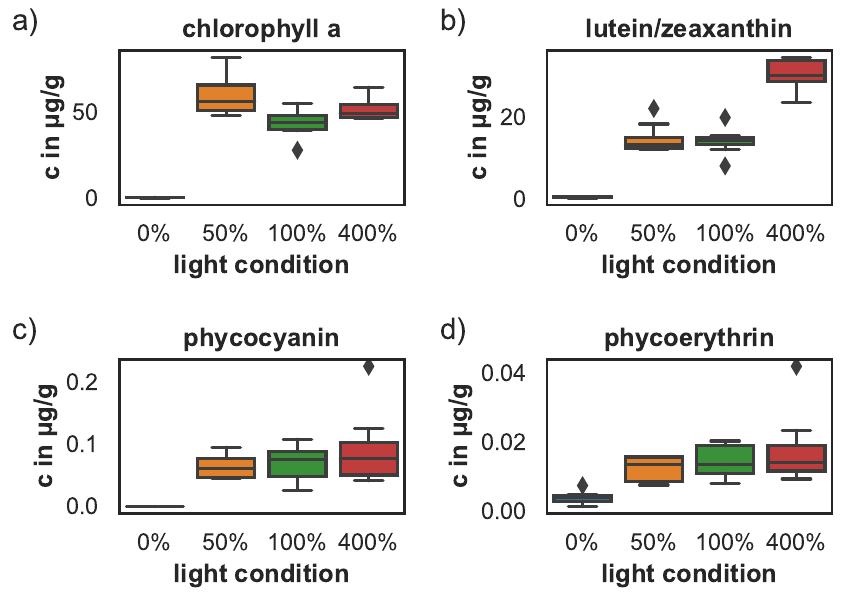
Figure 3. Pigment concentrations after 68 days under varying light conditions. ( a ) chlorophyll a concentrations, ( b ) carotenoid concentrations, ( c ) phycocyanin concentrations, ( d ) phycoerythrin concentrations. The box shows the quartiles of the data-set while the whiskers show the rest of the distribution, except for outliers that are plotted as diamonds.